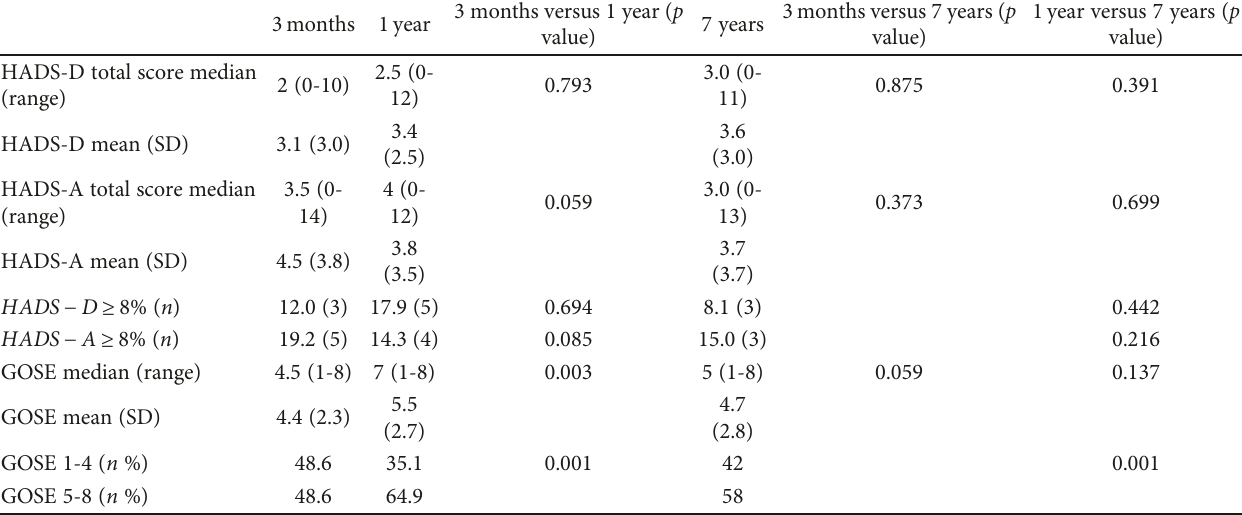
Table 3: HADS-depression (HADS-D), HADS-anxiety (HADS-A), and GOSE scores at 3 months, 1 year, and 7